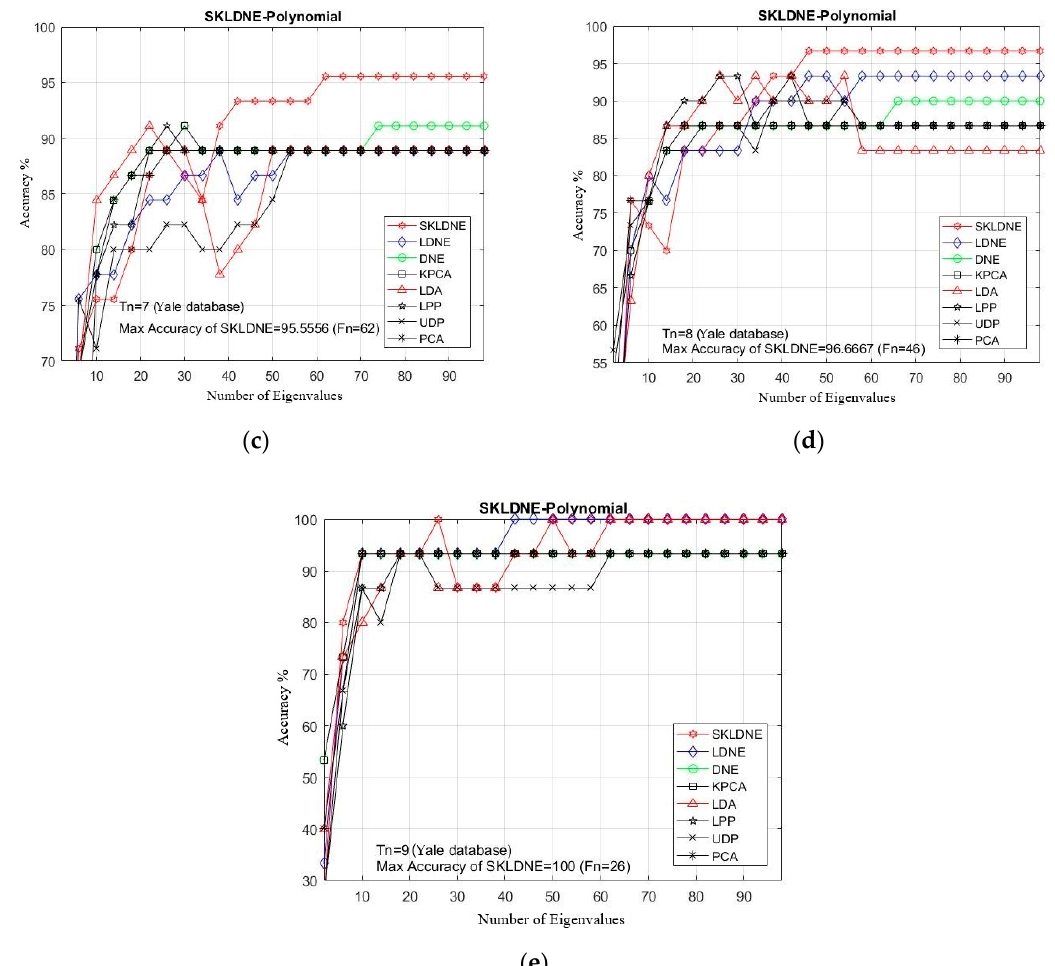
Figure 5. ( a – e ). The comparative recognition results changing the dimensionality of the transformation matrix for each given training number Tn on each dataset (Yale Face database).